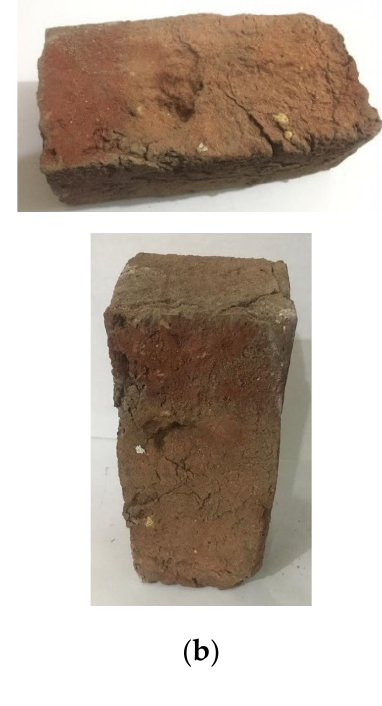
Figure 16. Surface appearance (a) coal ash brick (b) burnt clay brick.